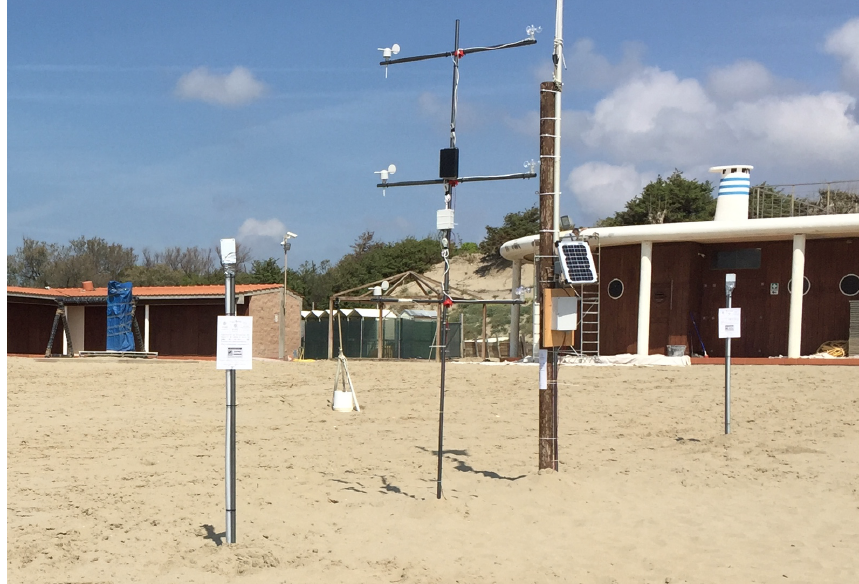
Figure 7. The sensor network deployed on the Marina di Tirrenia beach.